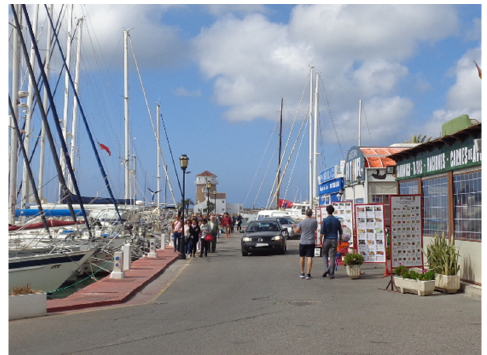
Figure 8. Incompatibility between pedestrian and vehicle traffic, Almerimar (Almería), ES. Figure 7. Incompatibility between pedestrian and vehicle traffic, Almerimar (Almer í a), ES.